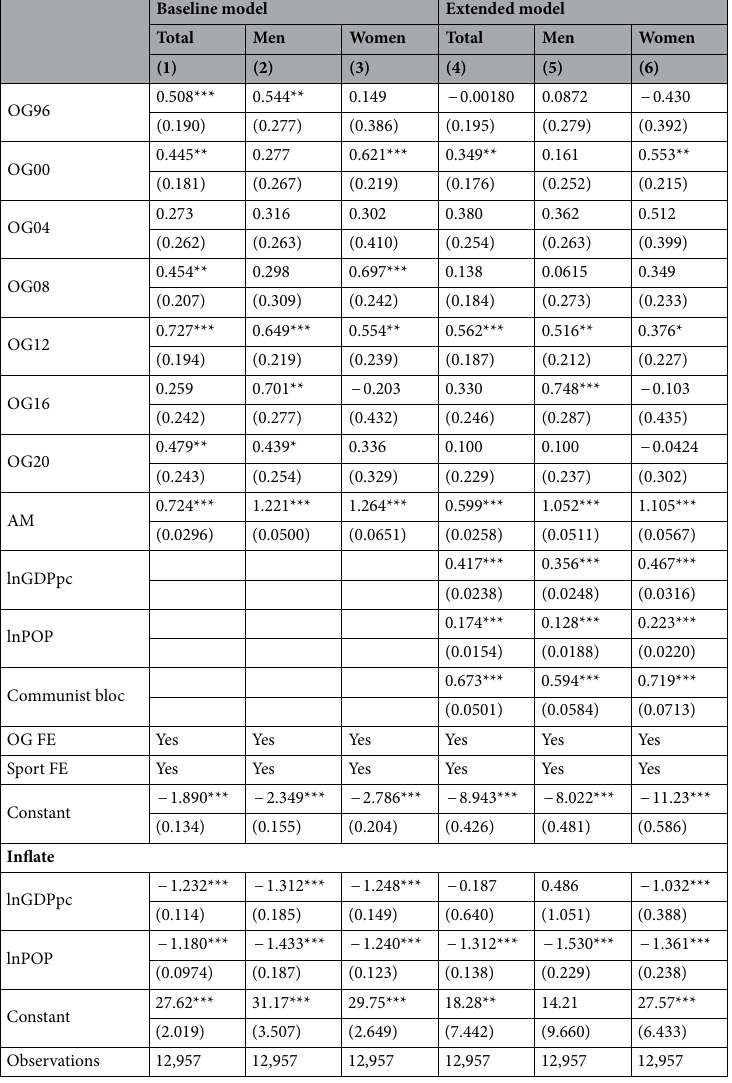
Table 2. Effects of hosting the Olympic Games by host. Robust standard errors in parentheses. * p < 0.1, ** p < 0.05, *** p <